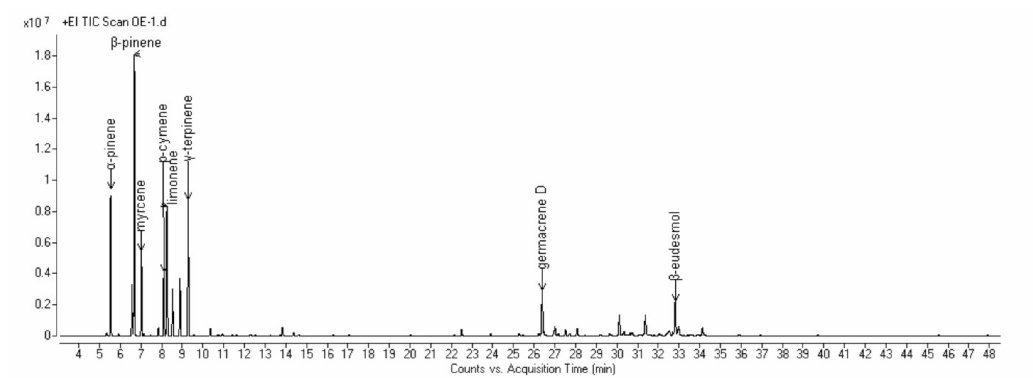
Figure 1. GC chromatogram of the EO hydrodistilled from the aerial parts of A. campestris L.